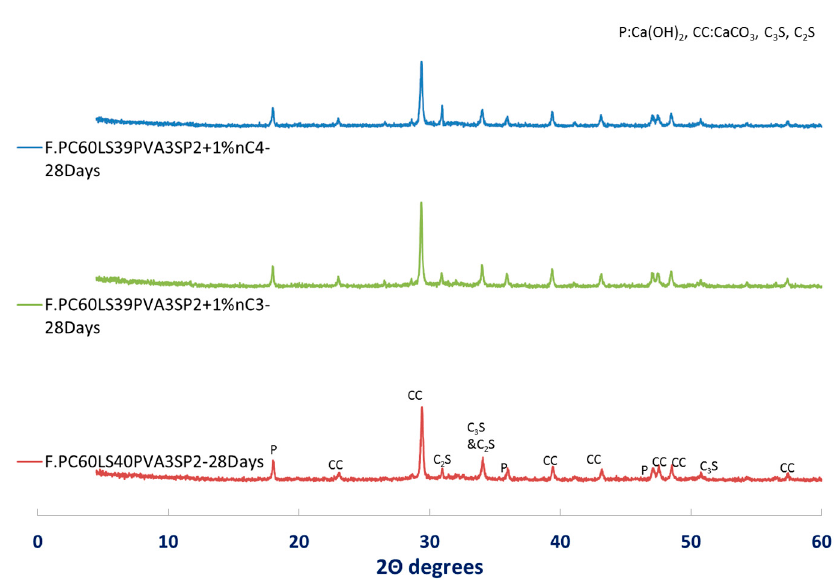
Figure 10. XRD pattern of fiber–cement nanohybrids based on F.PC60LS40PVA3SP2 at day 28—effect of nMt type.